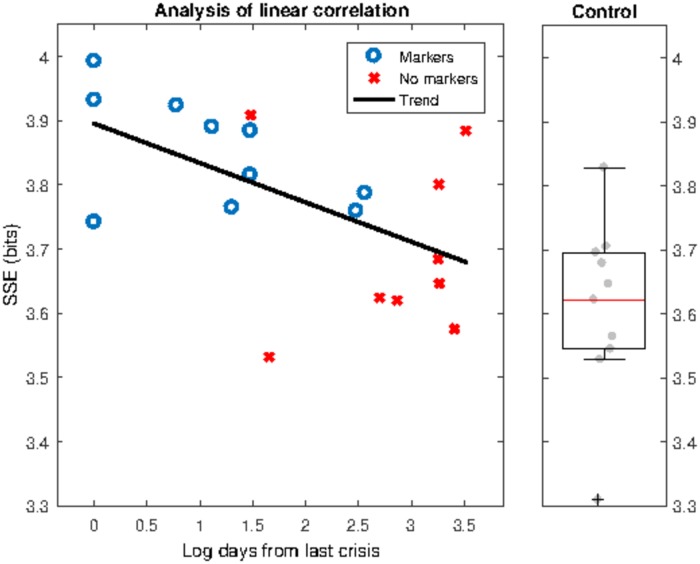
Linear fit of SSE vs time elapsed (log10) from last crisis (left) and boxplot of the SSE of healthy subjects in the band of frequencies of interest (right).The fit suggests that the SSE decreases as the time from the last crisis increases. Moreover, it should be noted that the SSE values seems to asymptotically converge in time to the levels of control subjects.